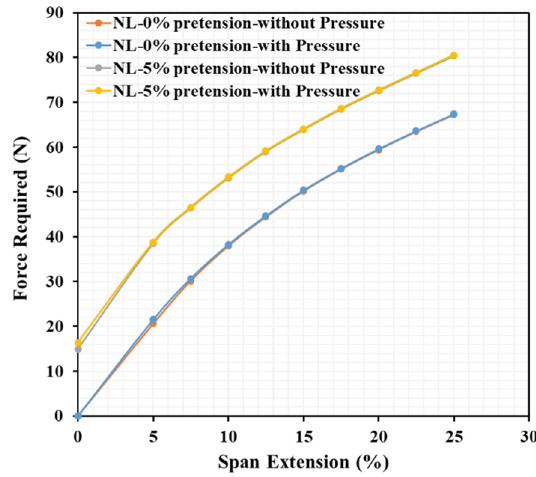
Figure 11. Actuation force for different span extensions at 0% and 5% pre-tensioning.